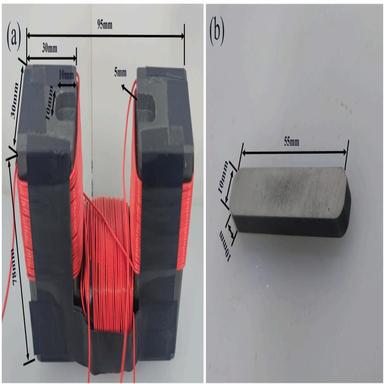
Geometry of (a) the U-shaped sensor, (b) the electromagnetic test sample.